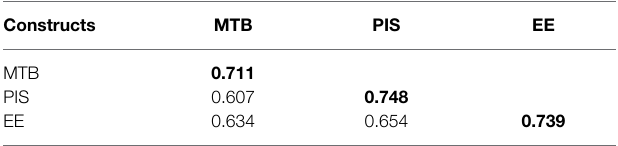
TABLE 4 | Discriminant